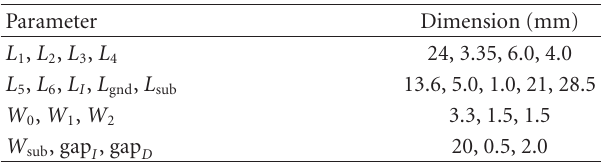
Figure 1: Chip inductor’s equivalent circuit elements versus fre- quency. Table 1: Proposed antenna